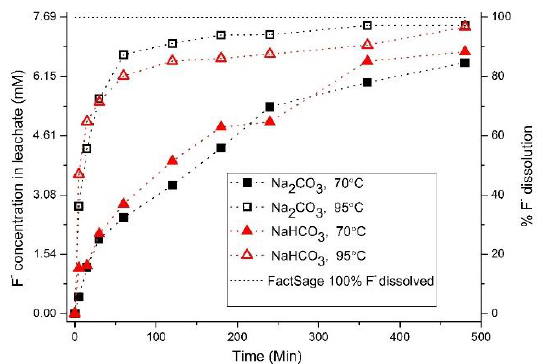
Figure 2. Experimental data for dissolution of CaF 2 at pH 9.0 as a function of time in comparison with thermodynamically calculated concentration based on the experimental conditions.